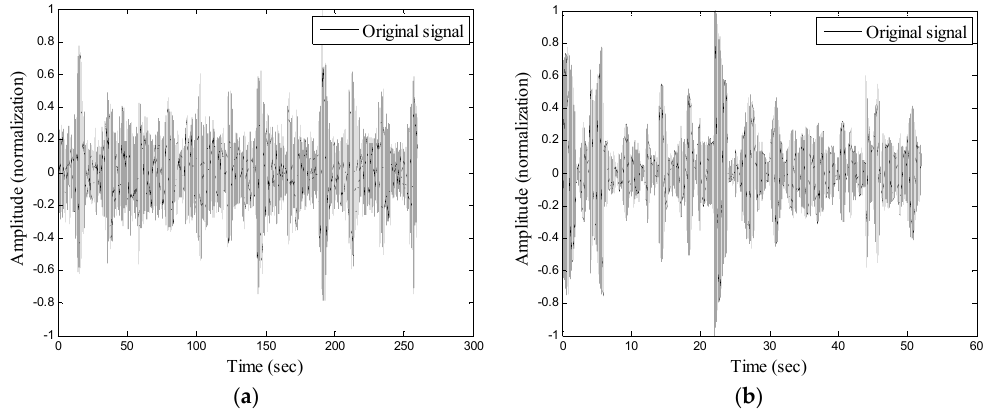
Figure 6. Charts of the original signals of radar waves at a tilt angle of 30 ˝ : ( a ) speed = 0.2 m/s; and ( b ) speed = 1.0